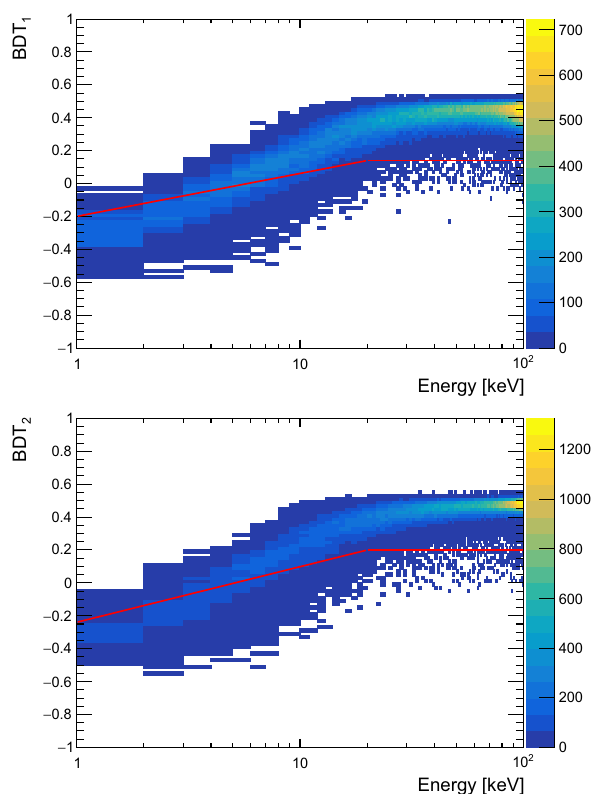
Fig. 9 BDT 1 (top) and BDT 2 (bottom) classifiers output for the 108m Ag data, with superimposed energy dependent threshold in red